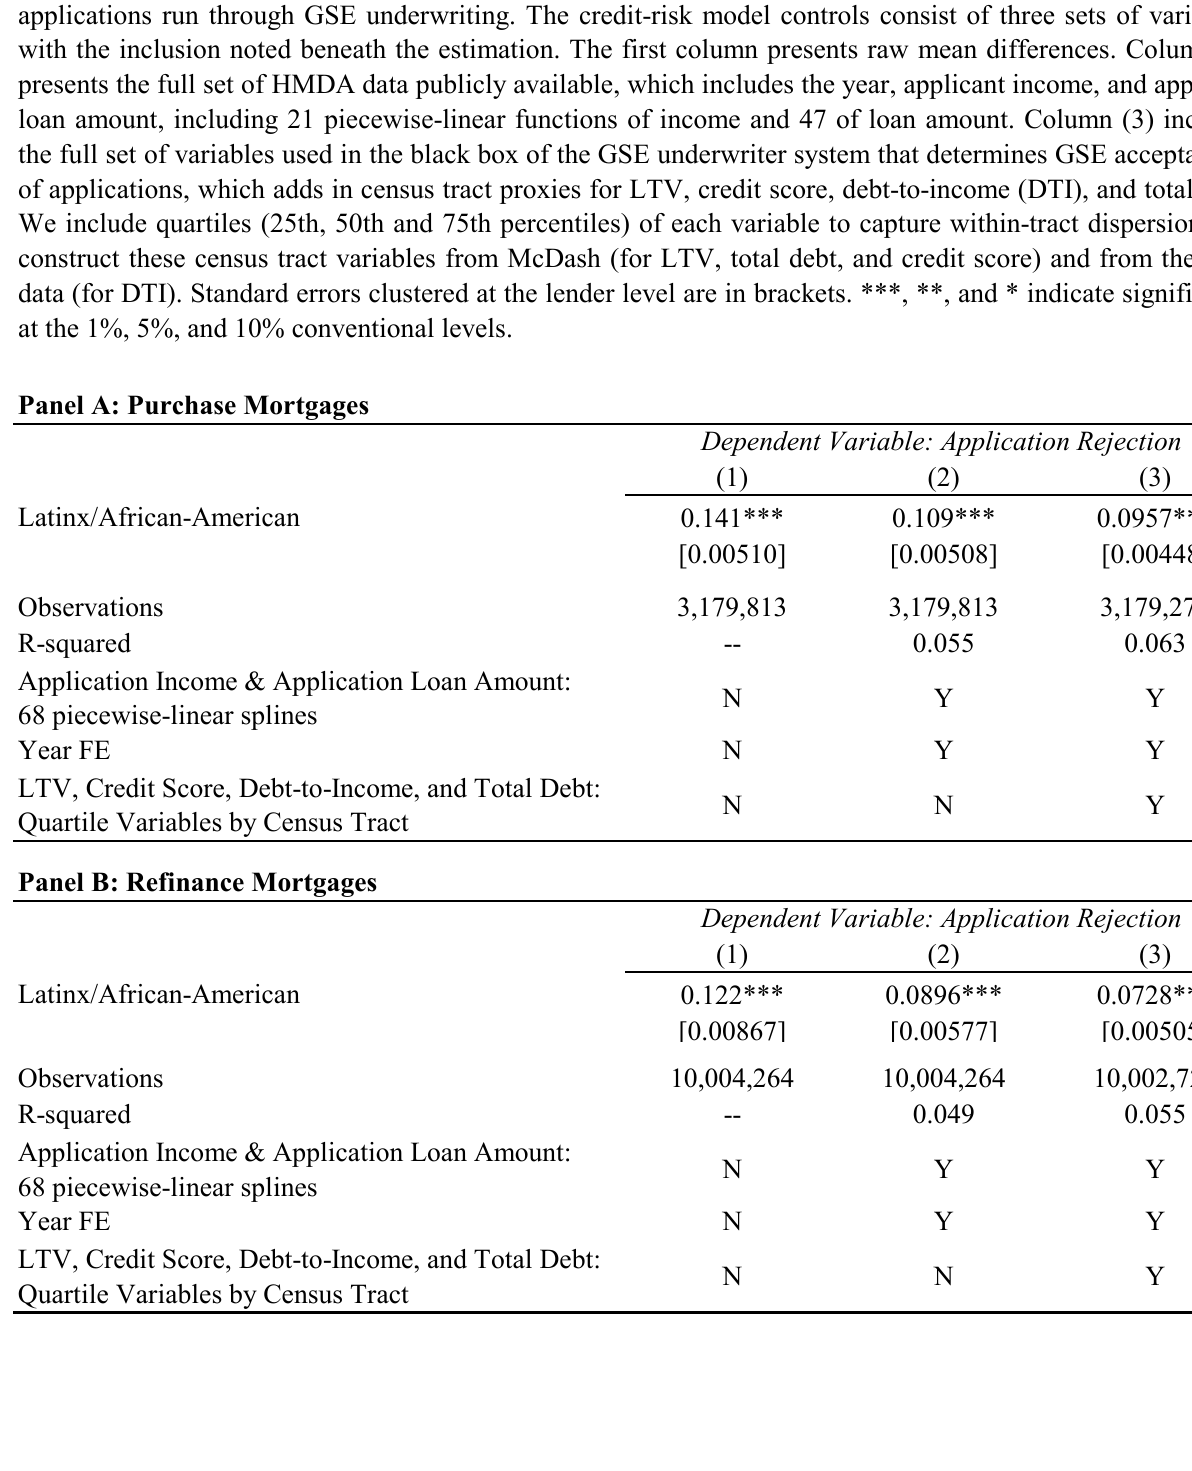
Table 7: Application Rejection